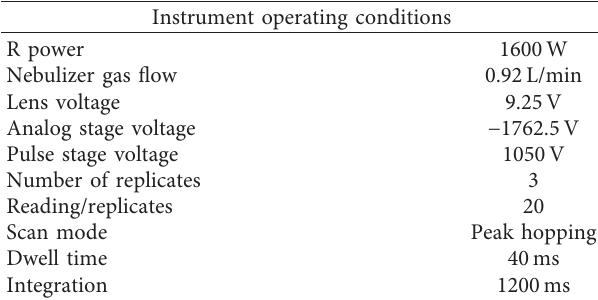
Table 1: Instrument operating conditions for the determination of metallic species in R. raetam